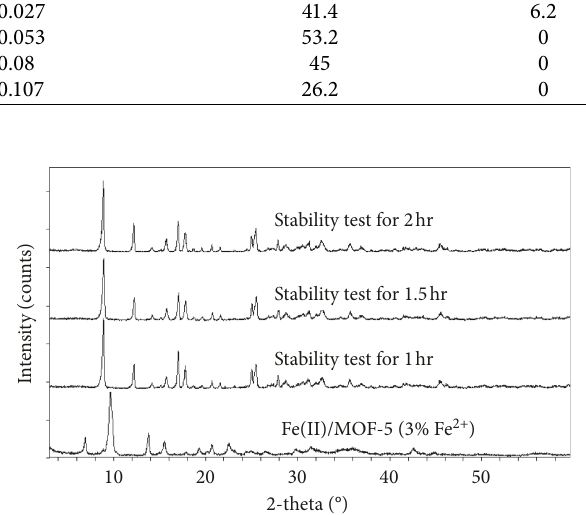
Figure 11: XRD contrast chart of Fe(II)/MOF-5 (3% Fe 2+ ) before and after the stability